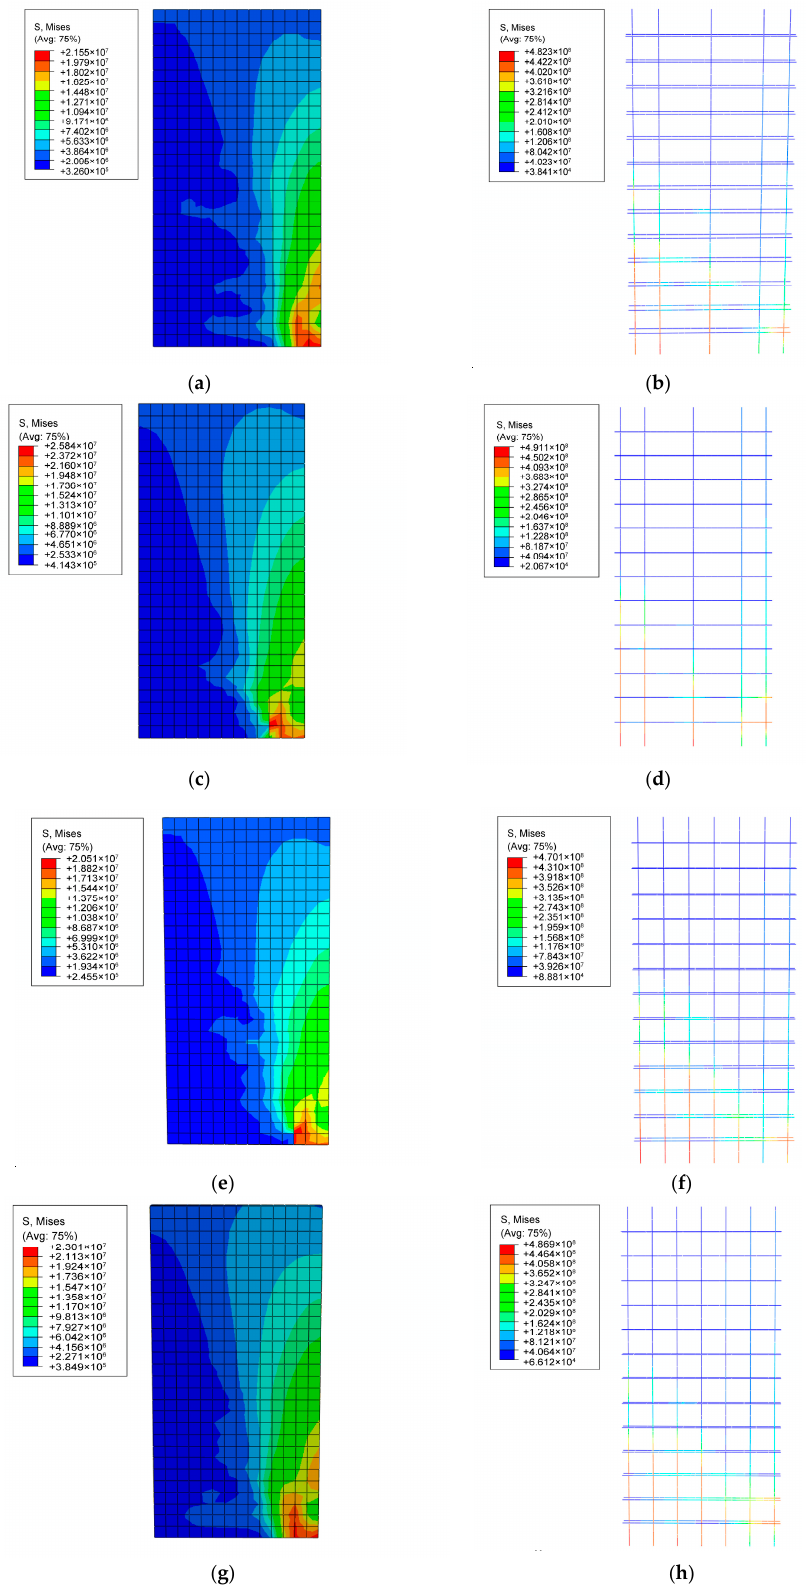
Figure 16. Stress cloud of the specimens: ( a ) Masonry stress of PMW-1; ( b ) steel stress of PMW-1; ( c ) masonry stress of PMW-2; ( d ) steel stress of PMW-2; ( e ) masonry stress of PMW-3; ( f ) steel stress of PMW-3; ( g ) masonry stress of PMW-4; and ( h ) steel stress of PMW-4.